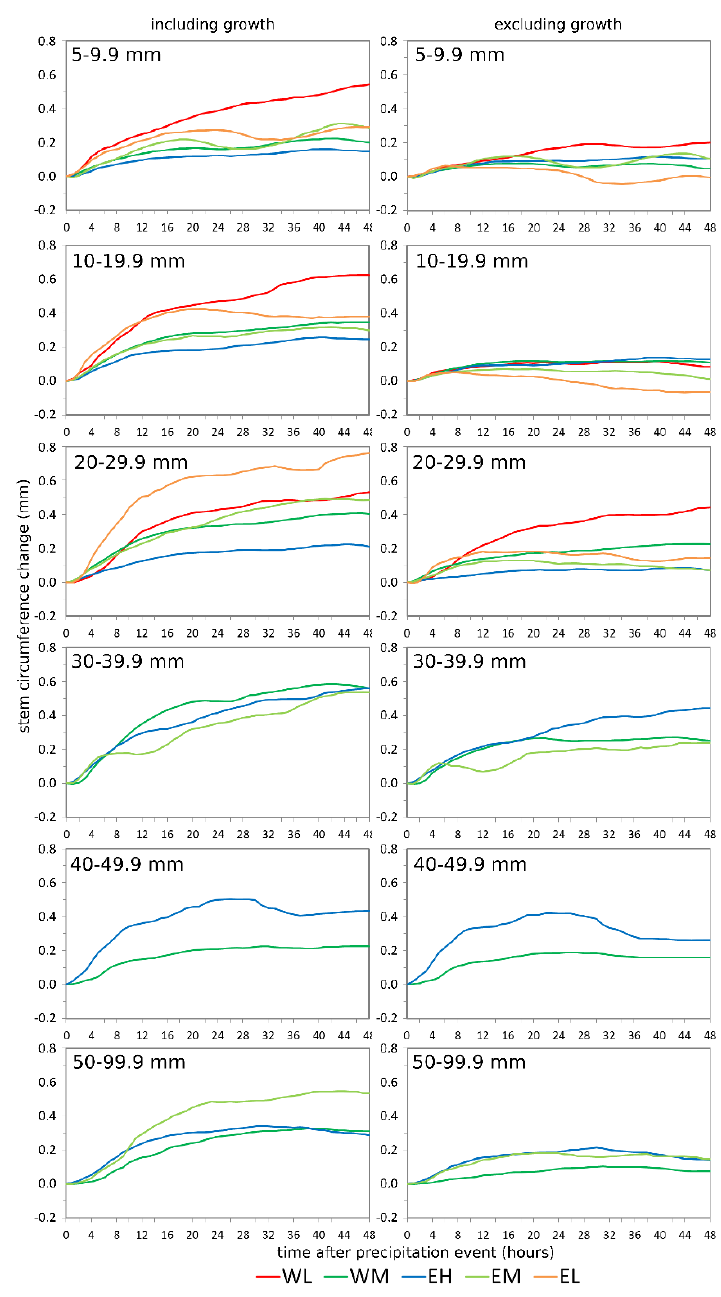
Figure 6. Mean stem circumference changes after precipitation events classified by precipitation amount, including ( left column ) and excluding ( right column ) tree growth. Stem circumference changes (SCC) curves are only shown for classes with at least two events per site. Precipitation events are extracted from the time period May 2017 to April 2019. Site codes refer to the east (E) and west (W) sides of Corsica, L, M, and H stand for low-, middle-, and high-elevation sites, respectively.